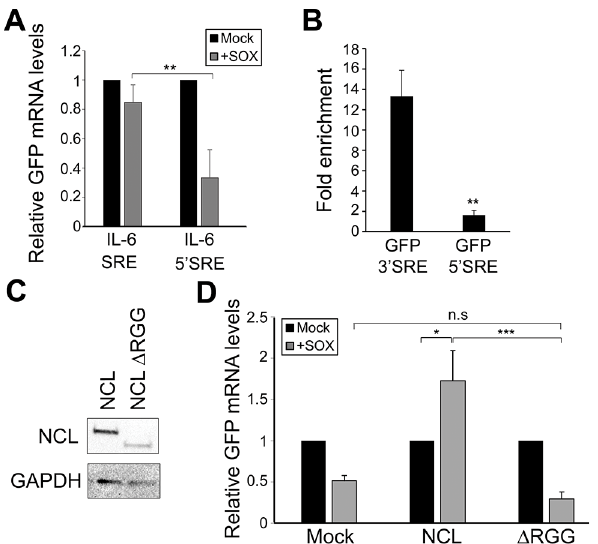
Fig 5. SRE-mediated protection is linked to its position and NCL protein-protein interactions. (A) 293T cells were co-transfected with the indicated GFP reporter plasmid in the presence or absence of SOX.